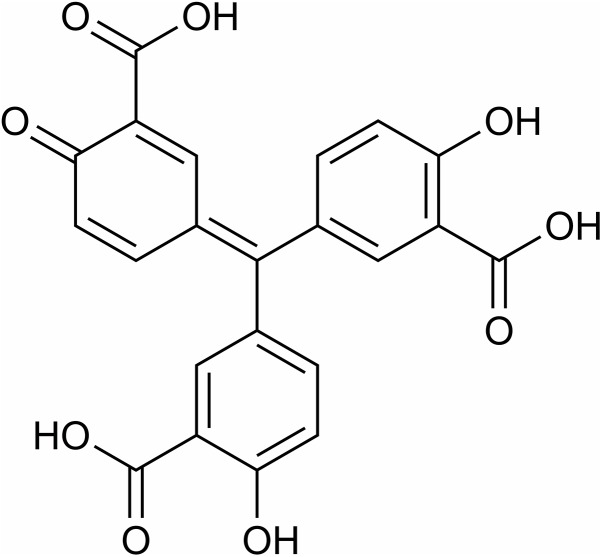
Aurintricarboxylic acid (ATA) structure. Molecular weight = 441.329 g/mol. Compound ID in PubChem: 2259.